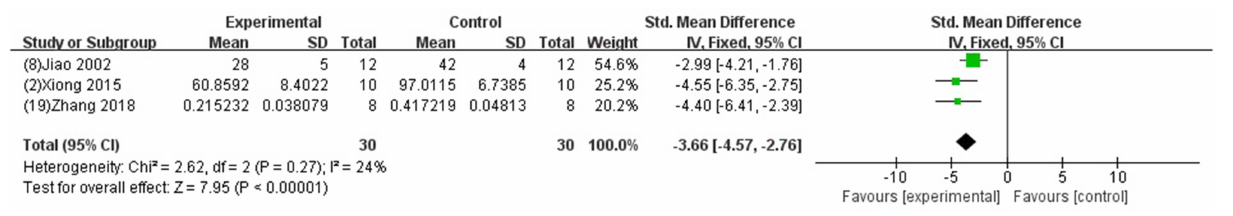
FIGURE 4 | Forest plot of animal studies investigating the effect of GB on myocardial infarction size (AAI/AAR) reduction.